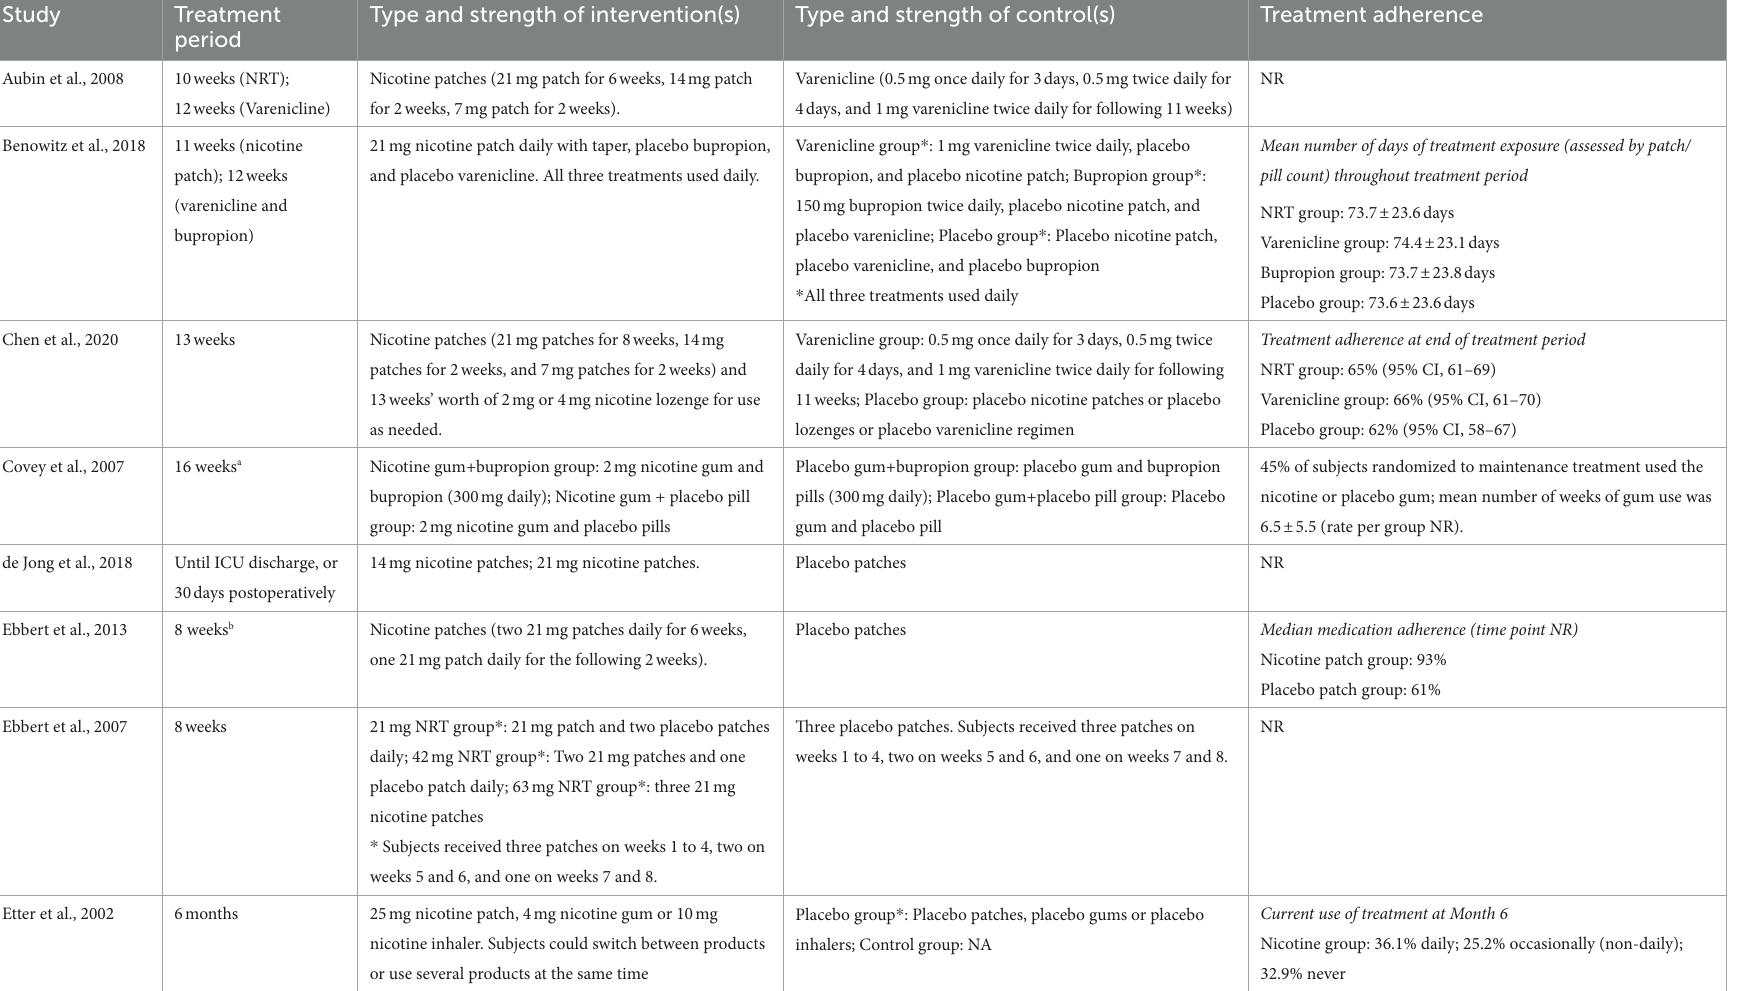
TABLE 5 Treatment protocol and adherence rates among included